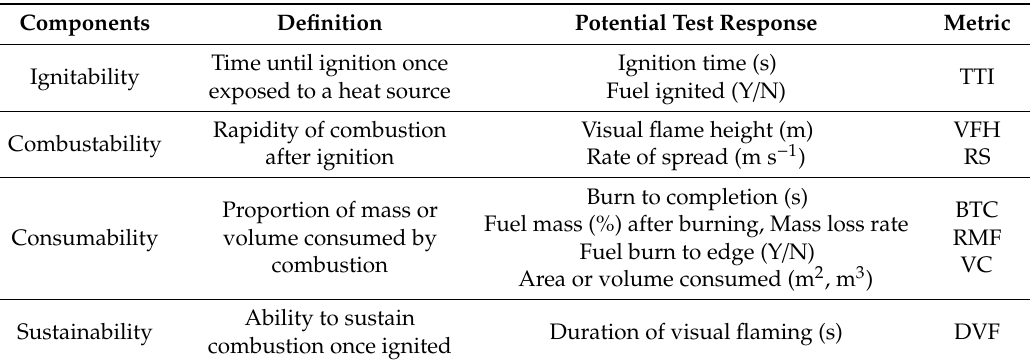
Table A1. Flammability components, their definitions and examples of fire test measurements, time to ignition (TTI), vertical fuel height (VFH), rate of spread (RS), burn to completion (BTC), residual mass fraction (RMF), volume consumed (VC), duration of visual flaming (DVF). (Source: adapted from White and Zipperer